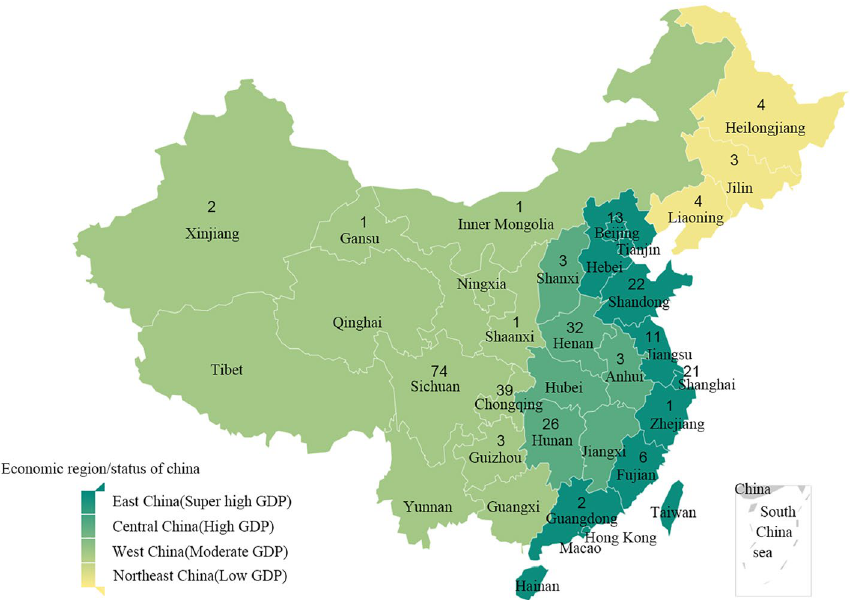
Figure 1. Economic regions distribution of included dialysis centers in China. GDP Gross domestic